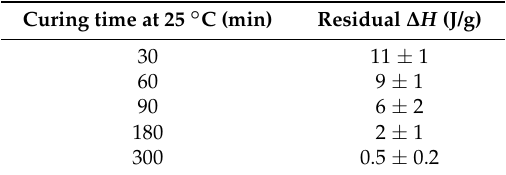
Table 3. Residual curing heat determined at different times for curing process of A formulation.